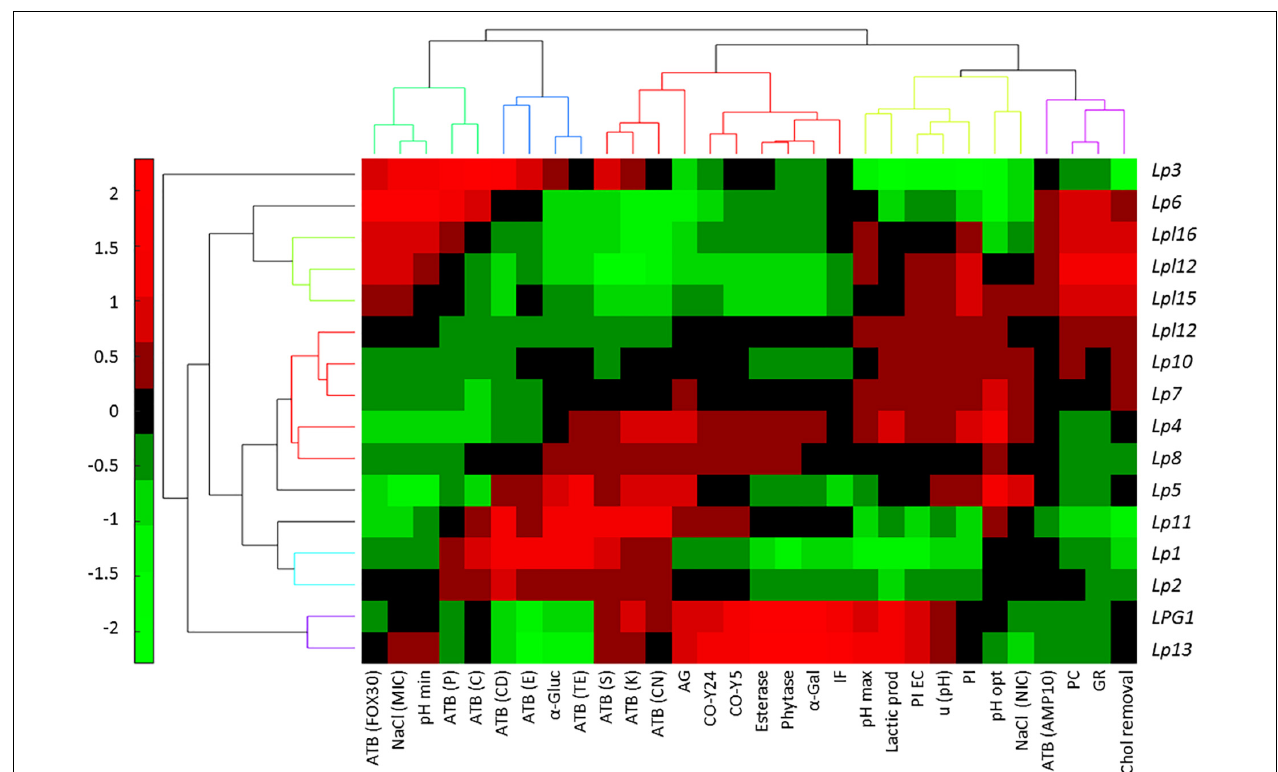
FIGURE 4 | Bicluster obtained after a multivariate analysis of genotypes, based on the probiotics and technological tests, using the Multibiplot Software. Cells’ colors represent the genotype contribution to each variable. The meanings of the abbreviations are: ATB(FOX30), antibiotic cefotaxime; NACl(MIC), minimum inhibitory concentration of sodium chloride; pH (min), minimum pH value; ATB(P10), penicillin antibiotic; ATB(C30), chloramphenicol antibiotic; ATB(CD2), clindamycin antibiotic; ATB(E15), erythromycin antibiotic; α -Gluc, α -glucosidase; ATB(TE), tetracycline antibiotic; ATB(S10); streptomycin antibiotic; ATB(K30), kanamycin antibiotic; ATB(CN10), gentamycin antibiotic; AG, auto-aggregation; CO-Y24, co-aggregation with yeast Y24; CO-Y5, co-aggregation with yeast Y5; Esterase; Phytase; α -Galact, α -galactosidase; IF, isolation frequency; pH max , maximum growth pH; Lactic prod, Lactic acid production; PI EC; E. coli inhibition; u (pH), maximum area obtained for pH; PL, Listeria monocytogenes inhibition; pH opt , optimum growth pH; NaCl(NIC), non-inhibitory concentration of sodium chloride; ATB(AMP10), ampicillin antibiotic; PC, pancreatic digestion; GR, gastric digestion; Chol removal, cholesterol